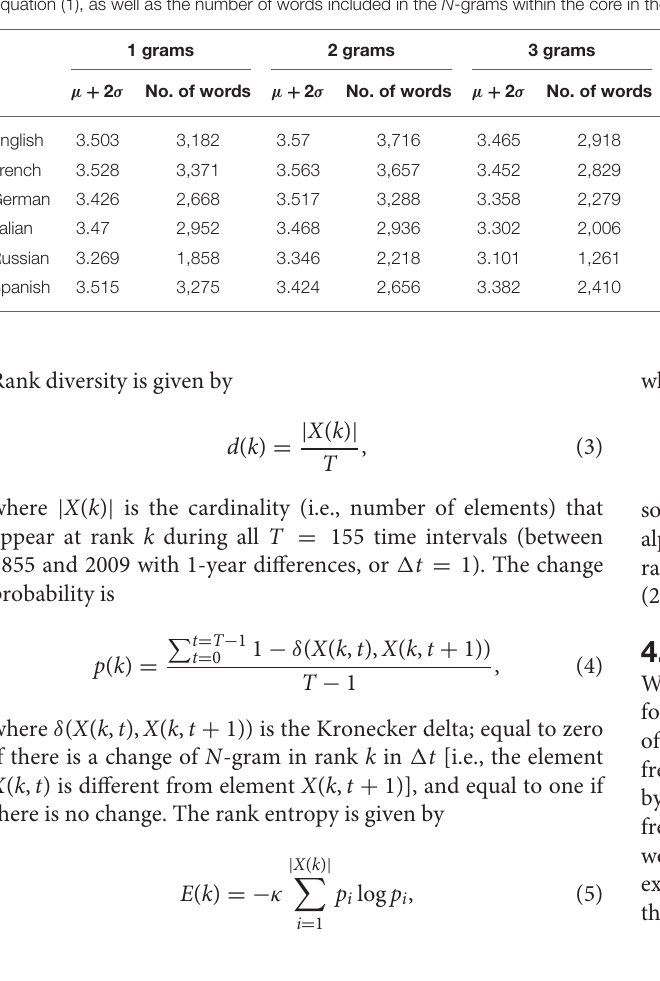
µ 2 σ for the estimated core size of all languages studied, according to the sigmoid fit of = +